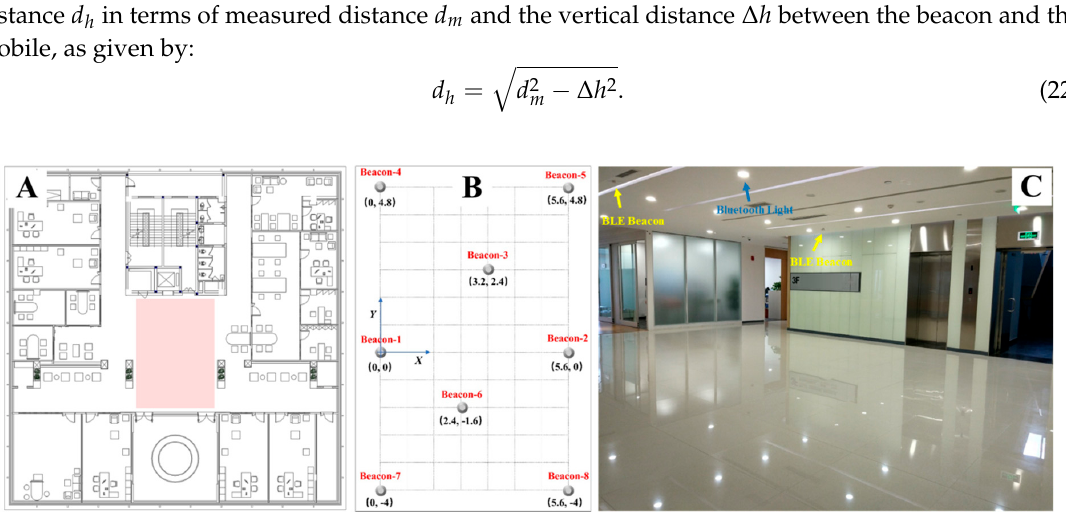
Figure 8. Layout of the test scenario.